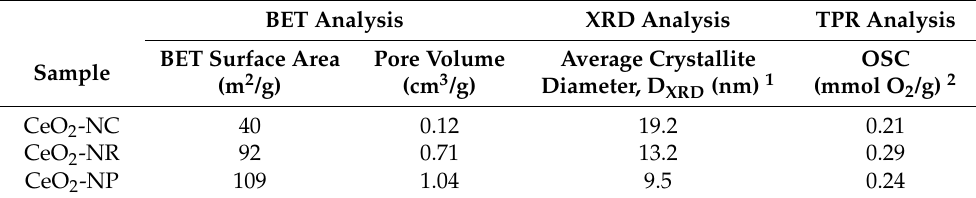
Table 2. Textural, structural and redox properties of bare ceria nanoparticles.